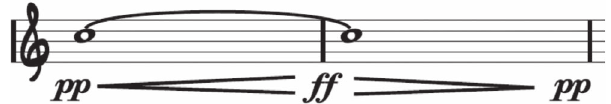
Figure 4. Musical task asked to the player. Recommended tempo: 70 bpm. Note that the musical staff shows written pitch C4, a tone higher than sounding pitch B [ 4.